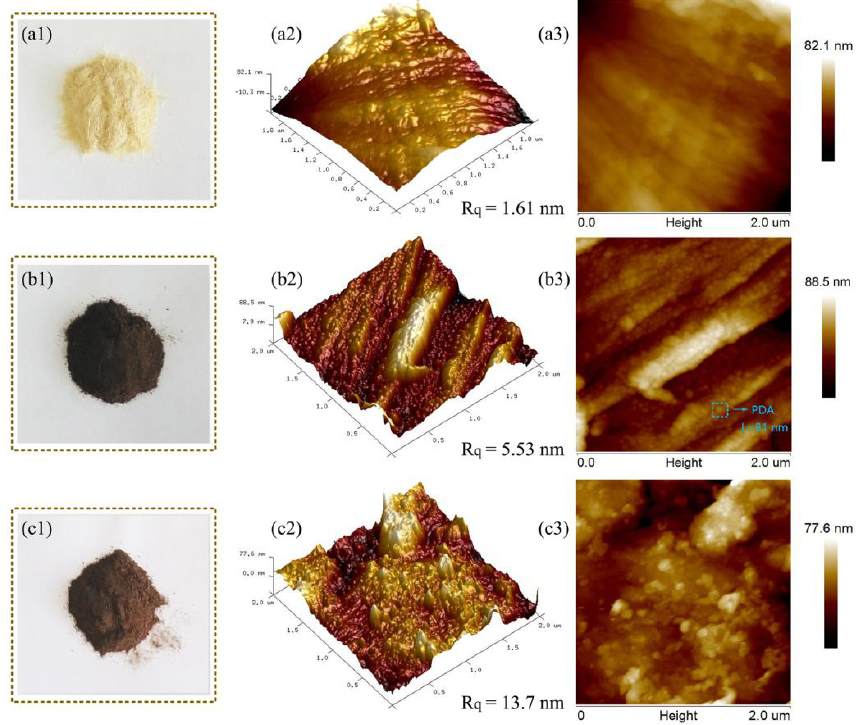
Figure 1. Optical photographs, atomic force microscopes (AFM) 3D and 2D height images of: ( a1 – a3 ) C–BFs; ( b1 – b3 ) PDA–BFs; and ( c1 – c3 ) PDA/ODA–BFs.